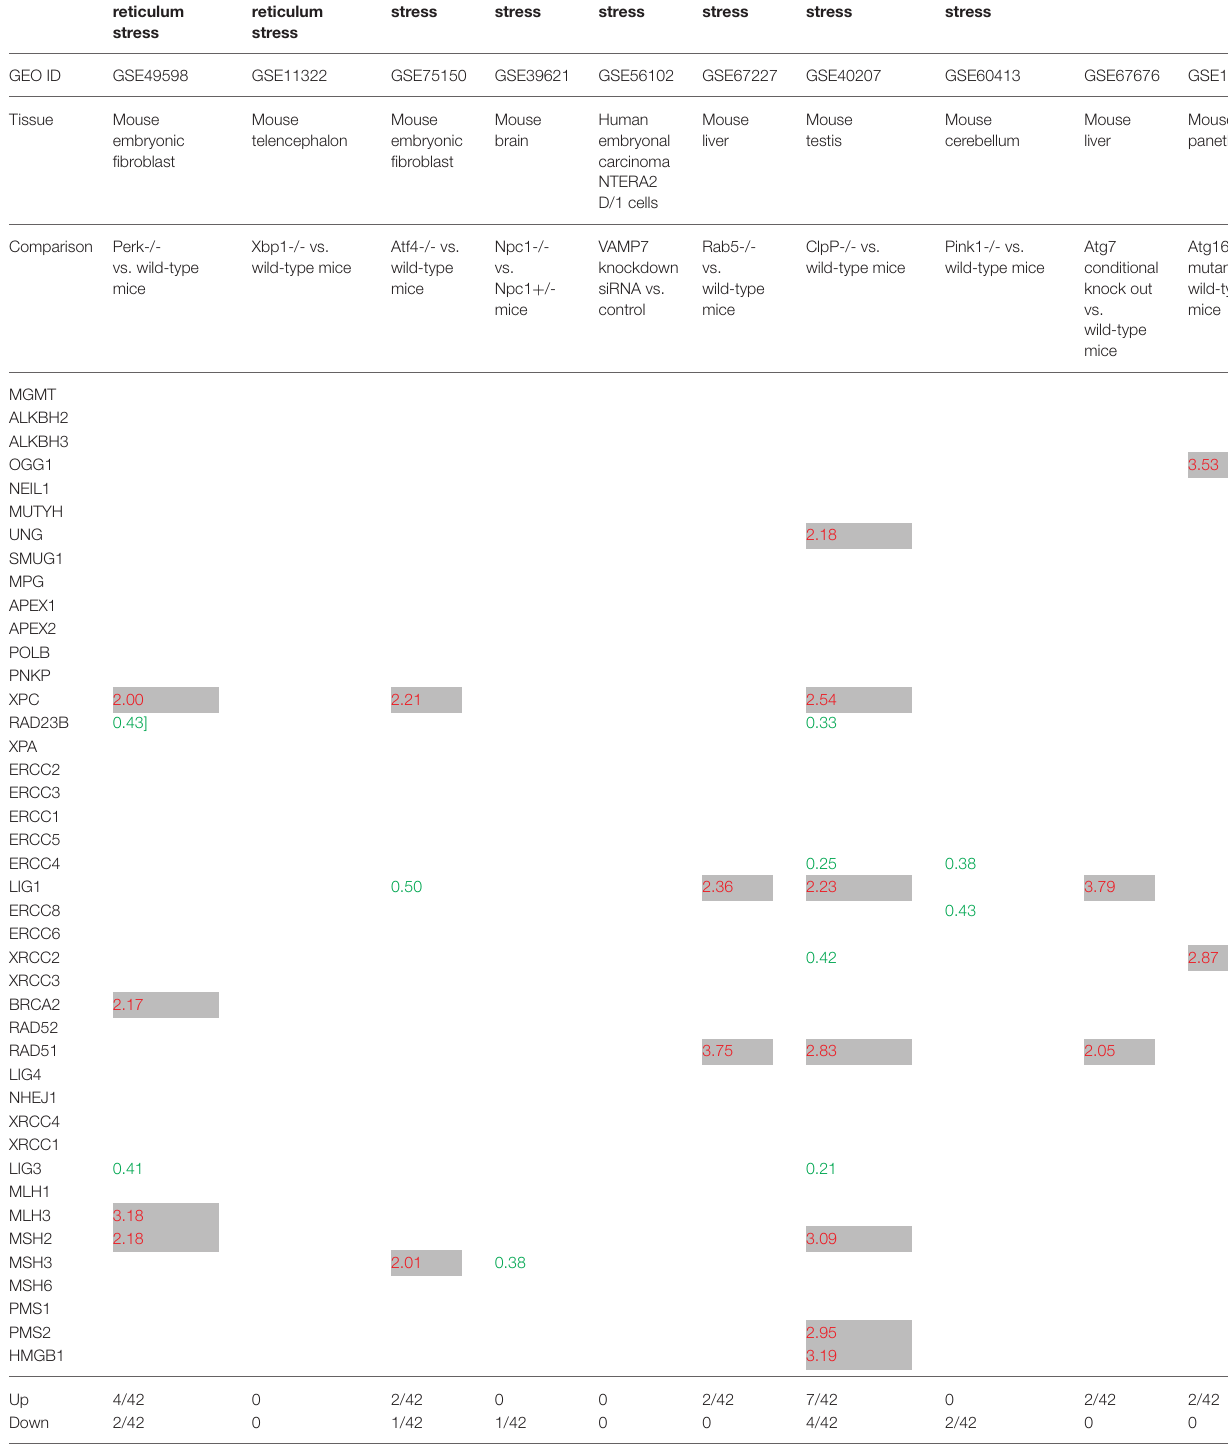
-Genes with significant expression changes (P < 0.05) are shown here. Red text stands for upregulation (FC ≥ 2), green text stands for downregulation (FC ≤ 0.5). Perk, protein kinase RNA-like endoplasmic reticulum (ER) kinase; Xbp1, X box-binding protein 1; Atf4, activating transcription factor 4; Npc1, Niemann Pick type C 1; Rab5, Ras-related protein Rab-5A; ClpP, ClpP caseinolytic peptidase, ATP-dependent, proteolytic subunit; Pink1, PTEN induced putative kinase 1; Atg7, Autophagy related 7; Atg16l1, Autophagy related 16-like 1; VAMP7, vesicle-associated membrane protein 7.